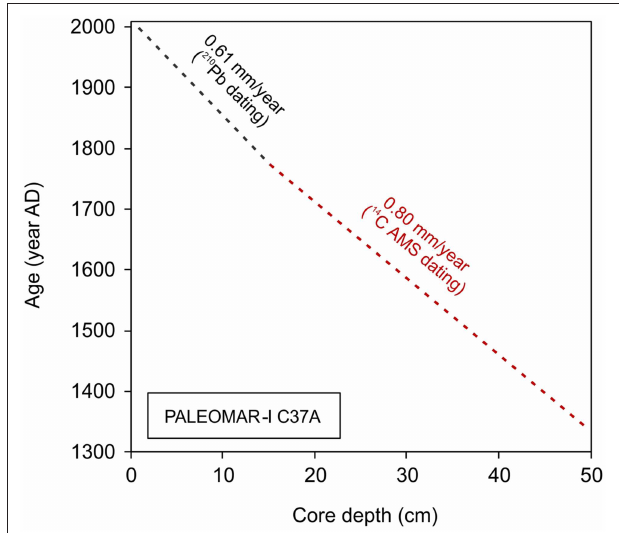
FIGURE 2 | Age model of core PALEOMAR-I C37A from Alfonso Basin.